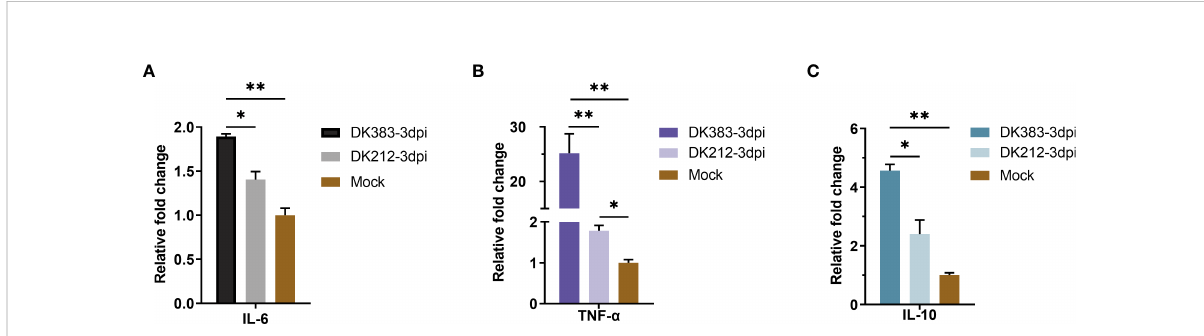
FIGURE 8 qPCR expression analysis of proin fl ammatory cytokine IL-6 (A) and TNF- a (B) and anti-in fl ammatory cytokine IL-10 (C) in the lungs of infected duck with the two HPAIVs at 3 dpi. Gene expression was normalized to the GAPDH gene expression level and is presented as the fold change relative to the level for the control group. Error bars indicate standard deviations. (*) P ≤ 0.05 and (**) P ≤ 0.01 compared with the result for DK212, respectively.